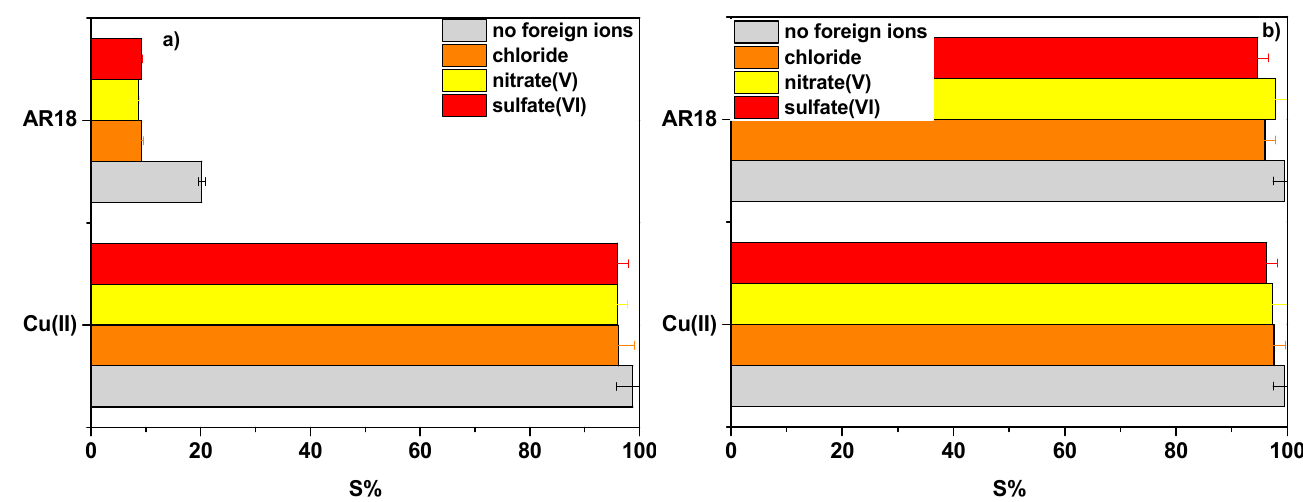
Figure 8. Effect of Cl − , NO 3 − , SO 42 − ions on the sorption percentage S(%) of AR18 and Cu(II) ions on ( a ) NaP1 and ( b ) NaP1CS, (m = 0.1 g, t = 120 min, A = 7, 180 rpm).